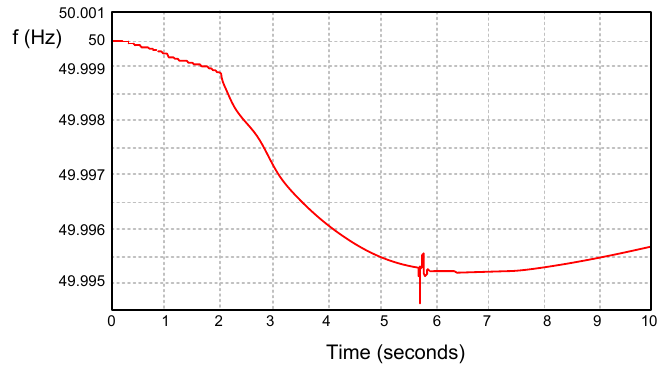
Figure 11. Frequency variation in 400 kV RTARIV1 bus.